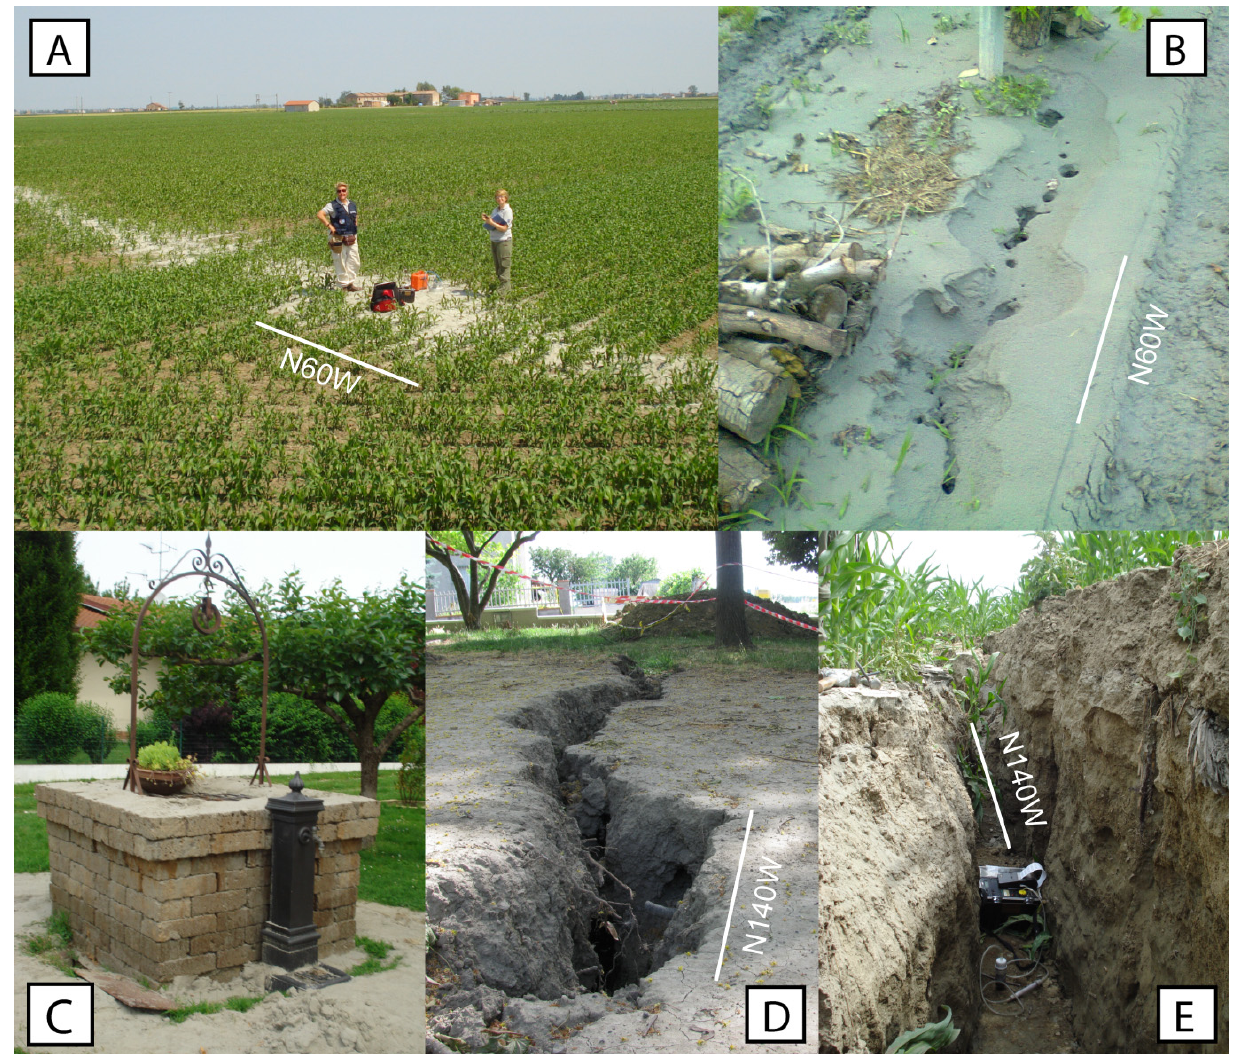
Figure 2. A, B. Liquefactions with N60W direction observed in Via della Fruttarola–Finale Emilia (Modena) corn field and Santa Bianca (Modena), re- spectively. C. Sand blowout from a well in San Carlo (Ferrara). D, E. Ground fractures with a N140W direction observed in the San Carlo area (Ferrara) soon after May 20, 2012 (see Figure 1 for location map). Geographic coordinates UTM WGS 84